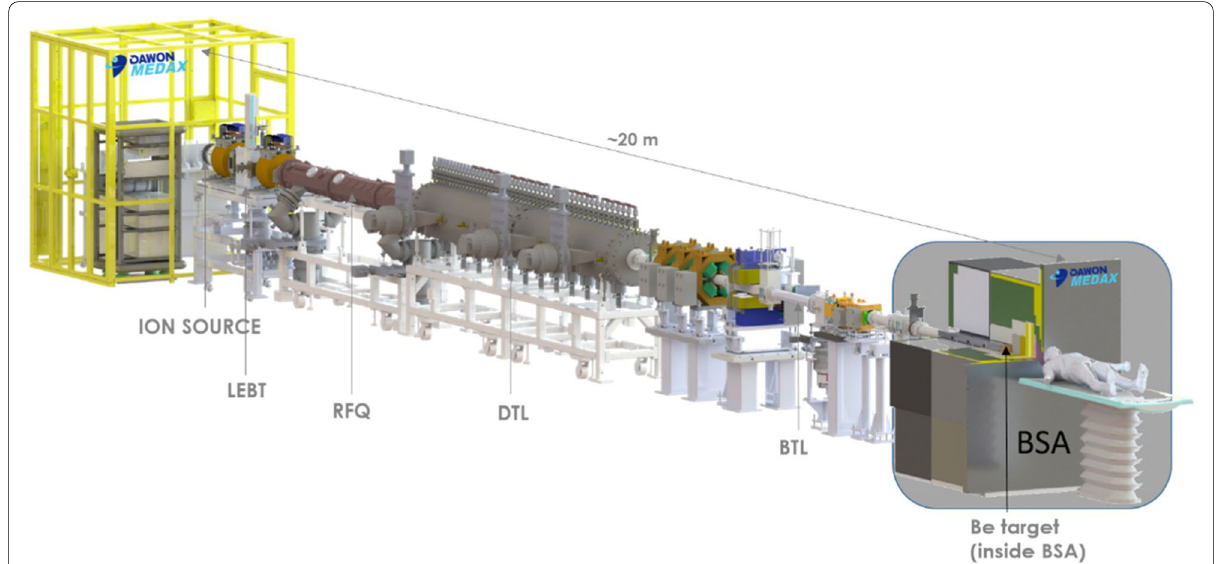
Fig. 8 Layout of the 10‑MeV proton linac and neutron generator with a beryllium target and